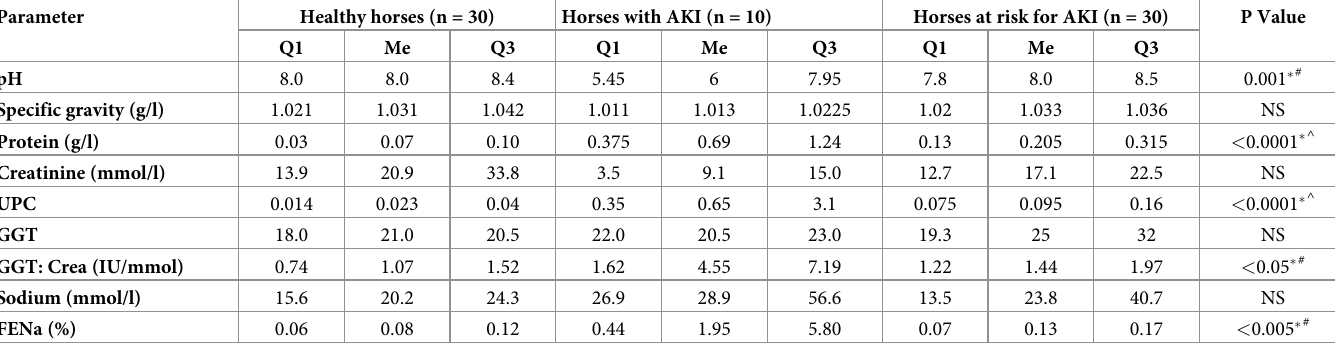
Crea (umol/l) 93.0 AST (U/l) GGT (U/l) AP (U/l) 172.0 CK (U/l) 196.0 227.0 Total protein (g/l) 59.0 63.0 Albumin (g/l) 31.0 32.0 Glucose (mmol/l) Sodium (mmol/l) 134.0